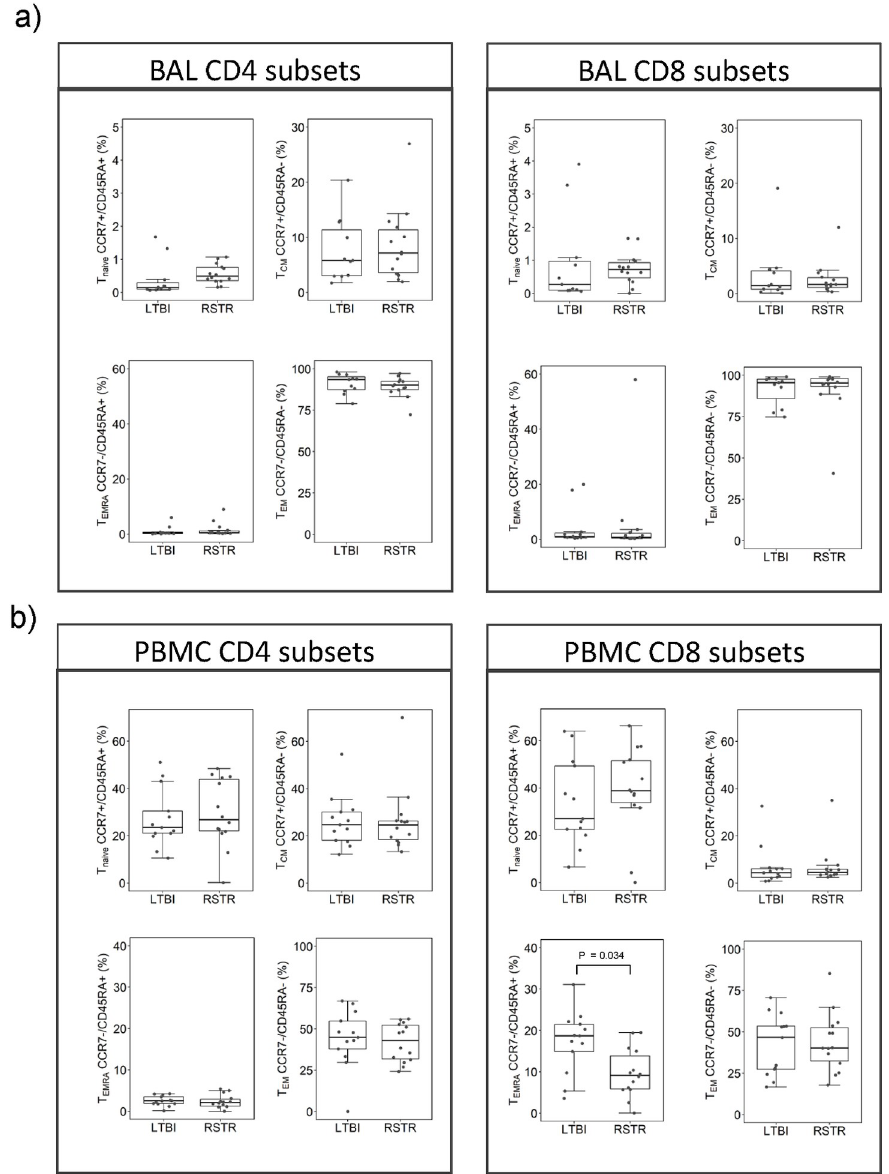
Fig 2. CD4+ and CD8+ cell subset percentages based on CD45RA and CCR7 gating. a) BAL lymphocyte subsets: N = 11 LTBI and14 RSTR, b) PBMC lymphocyte subsets: N = 13 LTBI and14 RSTR. PBMC CD8 T EMRA median percentage was larger in LTBI compared to RSTR (unadjusted P = 0.02/adjusted P = 0.034). Comparison of BAL vs PBMC: T EM median CD4+ and CD8+ percentages were larger in BAL compared to PBMC (P < 0.0001).